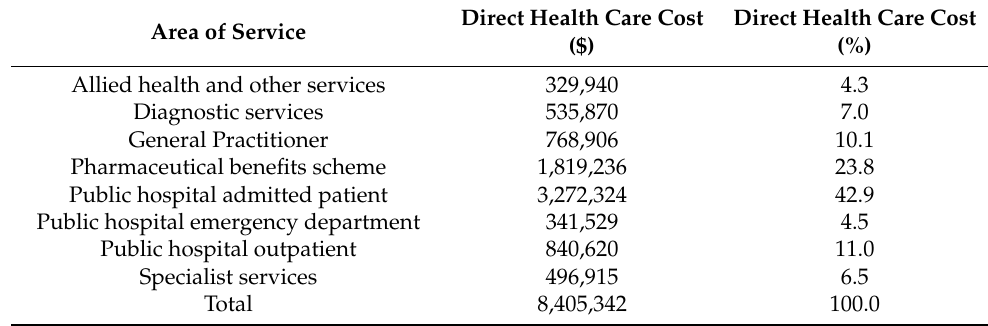
Table 6. Additional direct health care costs incurred due to LHL for those with a chronic condition (by area of health service) in the Blacktown LGA (Domain